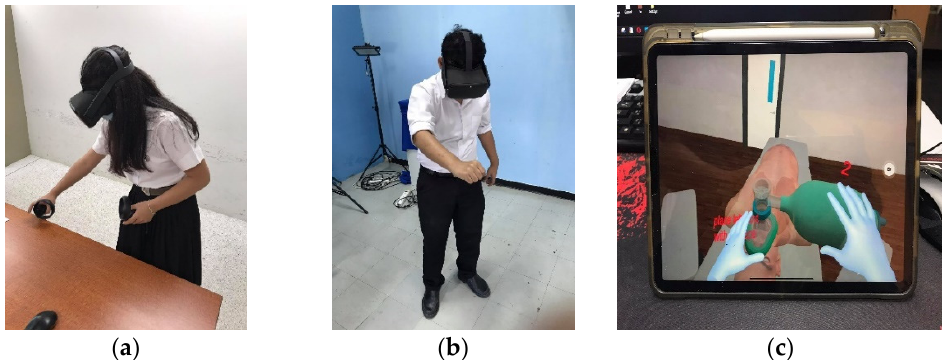
Figure 7. The experiment: ( a ) with VR controller; ( b ) with VR hand tracking; ( c ) Oculus Quest display cast to the iPad screen in real-time to see user interactions.